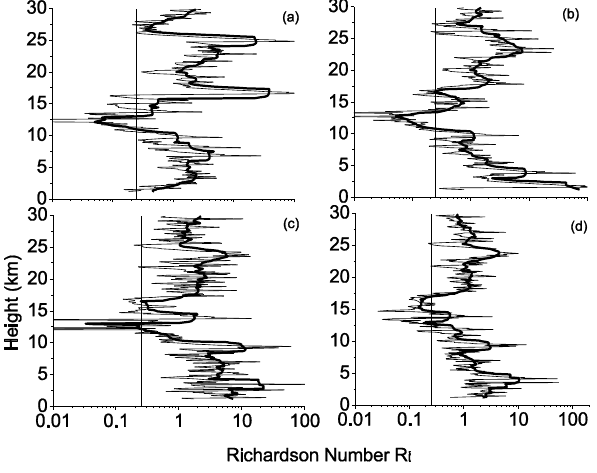
Figure 4 Richardson number profiles for 30 Nov 05 (a) before and (b) during convection (top panel), and for 09 Dec 05 (c) before and (d) during convection (bottom panel). Both the panels represent convective days' observation. Note that a vertical line at 0.25 on x-axis denotes demarcation between states of turbulence and stable atmosphere. Dark line represents average profile using running mean of 1.5 km.